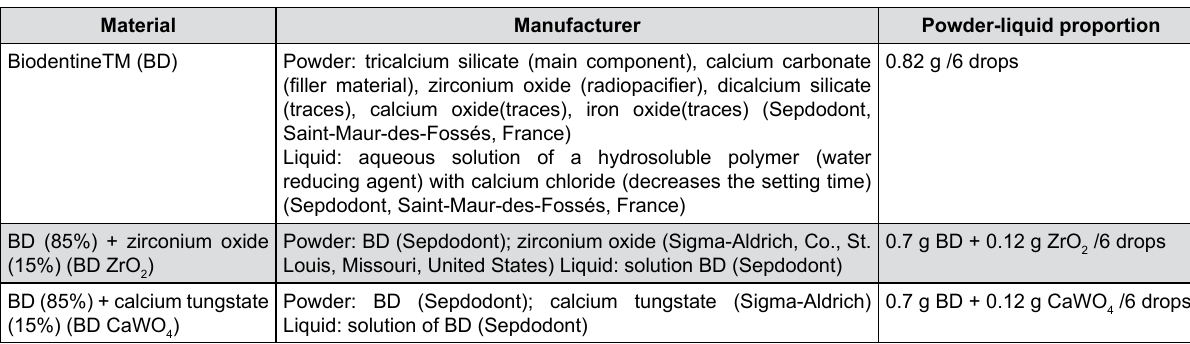
Figure 1- Materials, composition, manufacturer and proportion